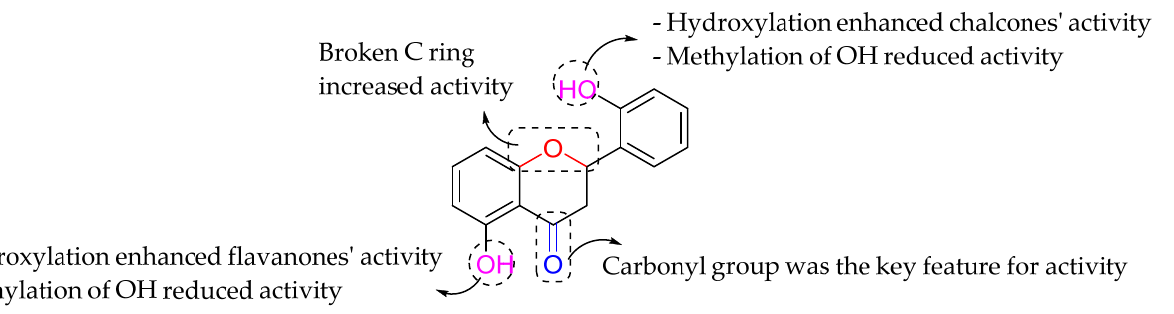
Figure 13. Important SAR of flavonoids as antibacterial agent against MRSA [79].